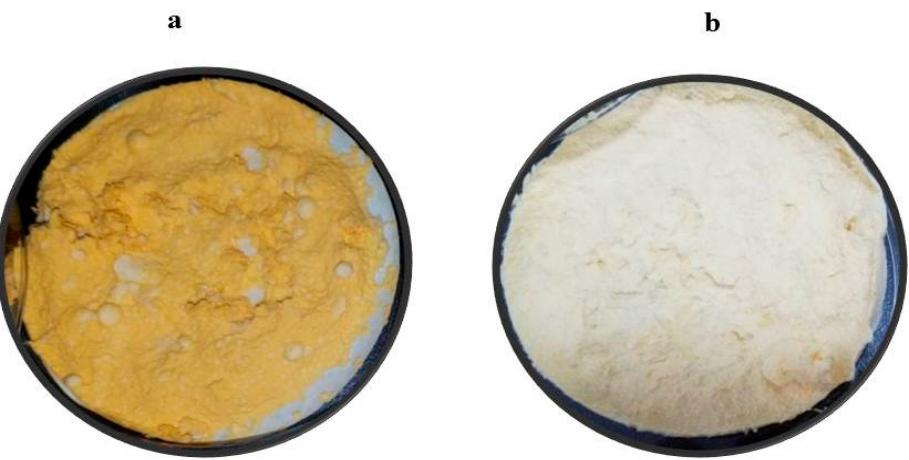
Figure 3. Mycelia appearance of ( a ) CBS 277.49 and ( b ) WJ11 after vacuum filtration and